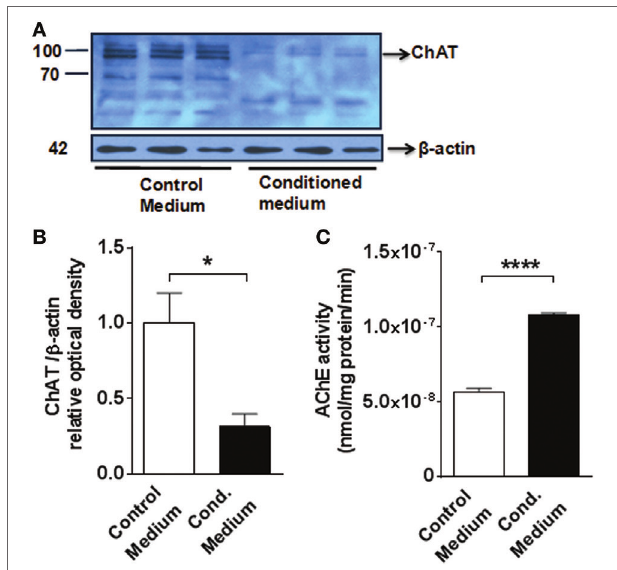
FigUre 6 | Medium from LPS-activated microglial cells decreases choline acetyltransferase (ChAT) protein expression and increases acetylcholinesterase (AChE) activity in mouse primary cortical neurons (a) western blot (MW 83 kDa) of ChAT of 7-day-old primary neuronal culture exposed to control or conditioned media (obtained from LPS-activated microglial BV2 cells). See Section “Materials and Methods” for details. (B) Fold change of the western blot determined using Image J to measure band intensities of ChAT normalized to β -actin.* P = 0.0343, Student’s t -test, n = 3 cultures per group, containing neurons obtained from five to six neonate brains each. (c) AChE activity in 7-day-old primary neuronal culture exposed to control or conditioned (Cond.) media **** P < 0.0001, Student’s t -test, n = 3 cultures per group, containing neurons obtained from five to six neonate brains each. The Student’s t -test was performed assuming normality and equal distribution of variance between the groups.